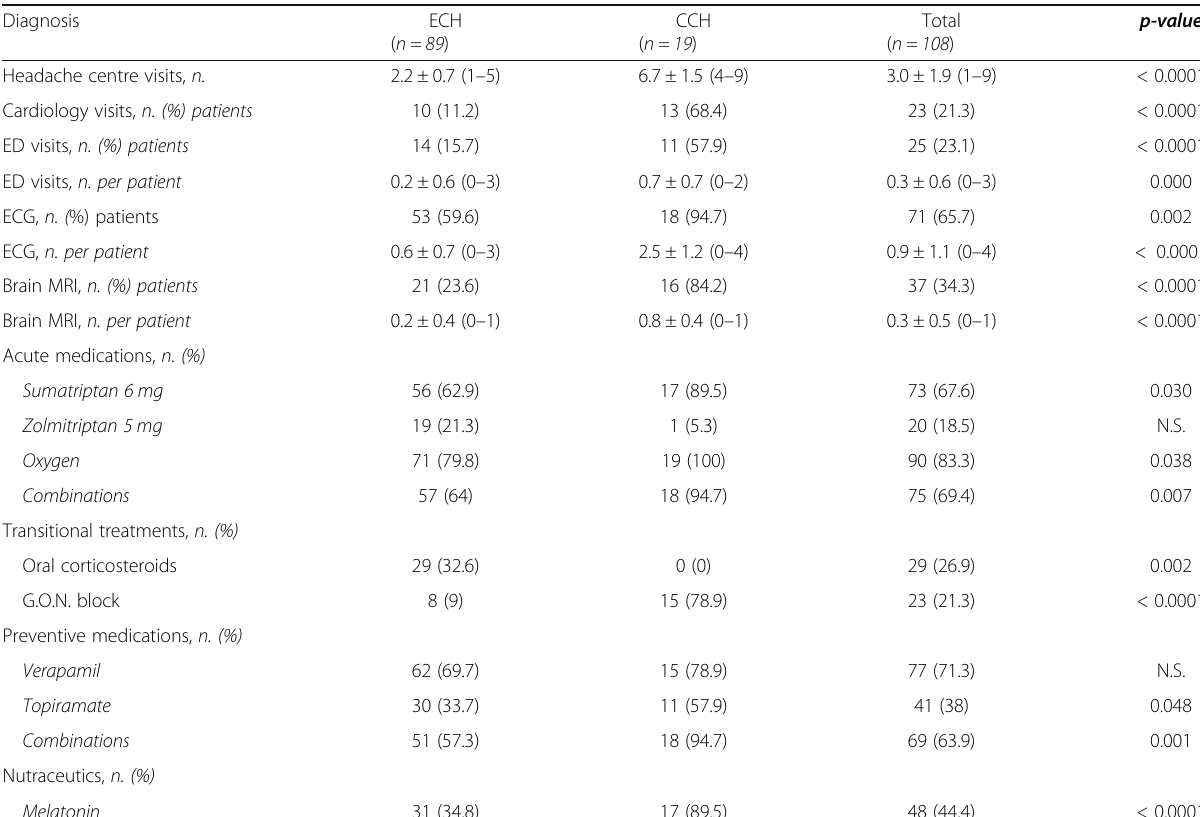
Table 2 Healthcare resource use